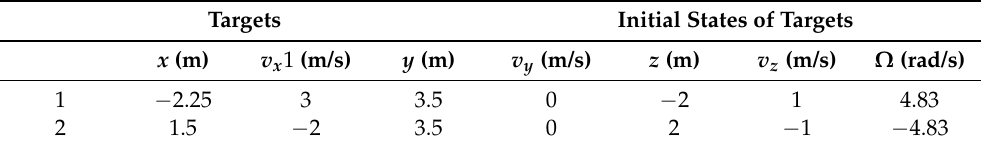
Figure 8. The radar and target geometry for Scenario 2. Table 2. Scenario 2.